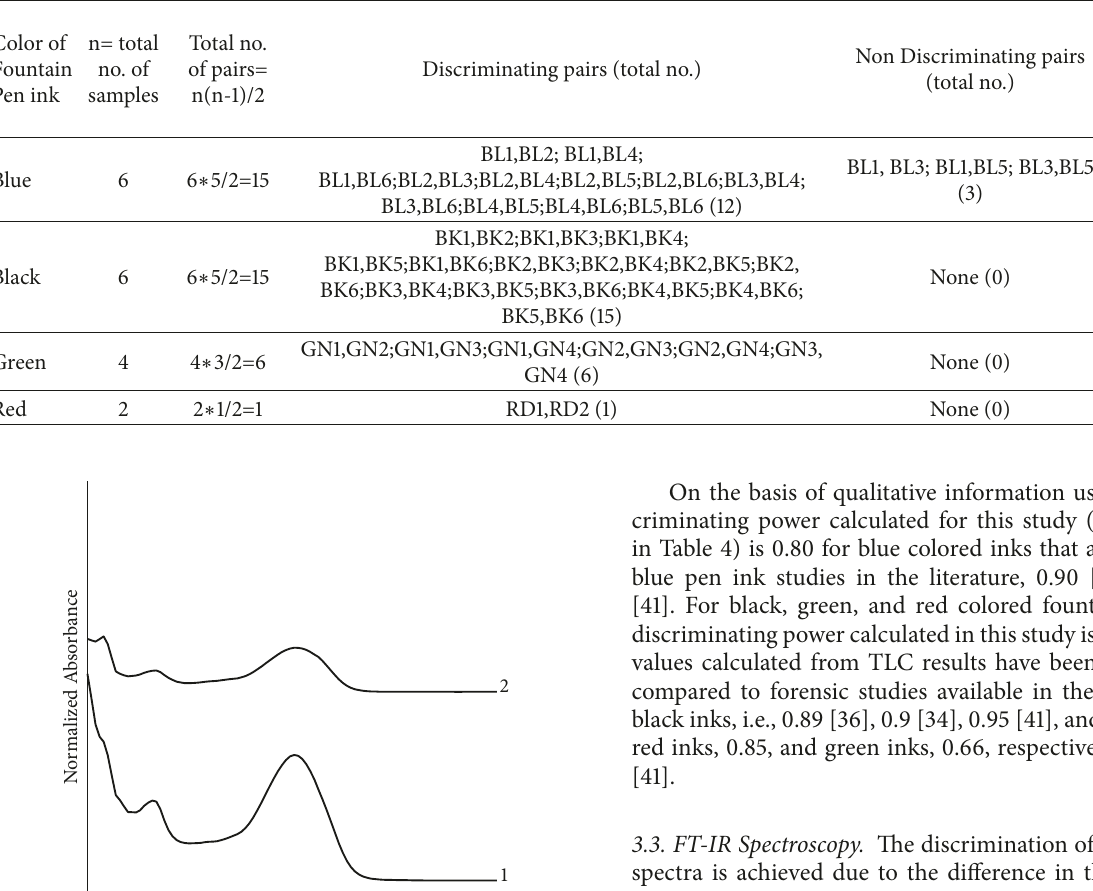
Table 4: Discriminating power of blue, black, green and red fountain pen inks using TLC.